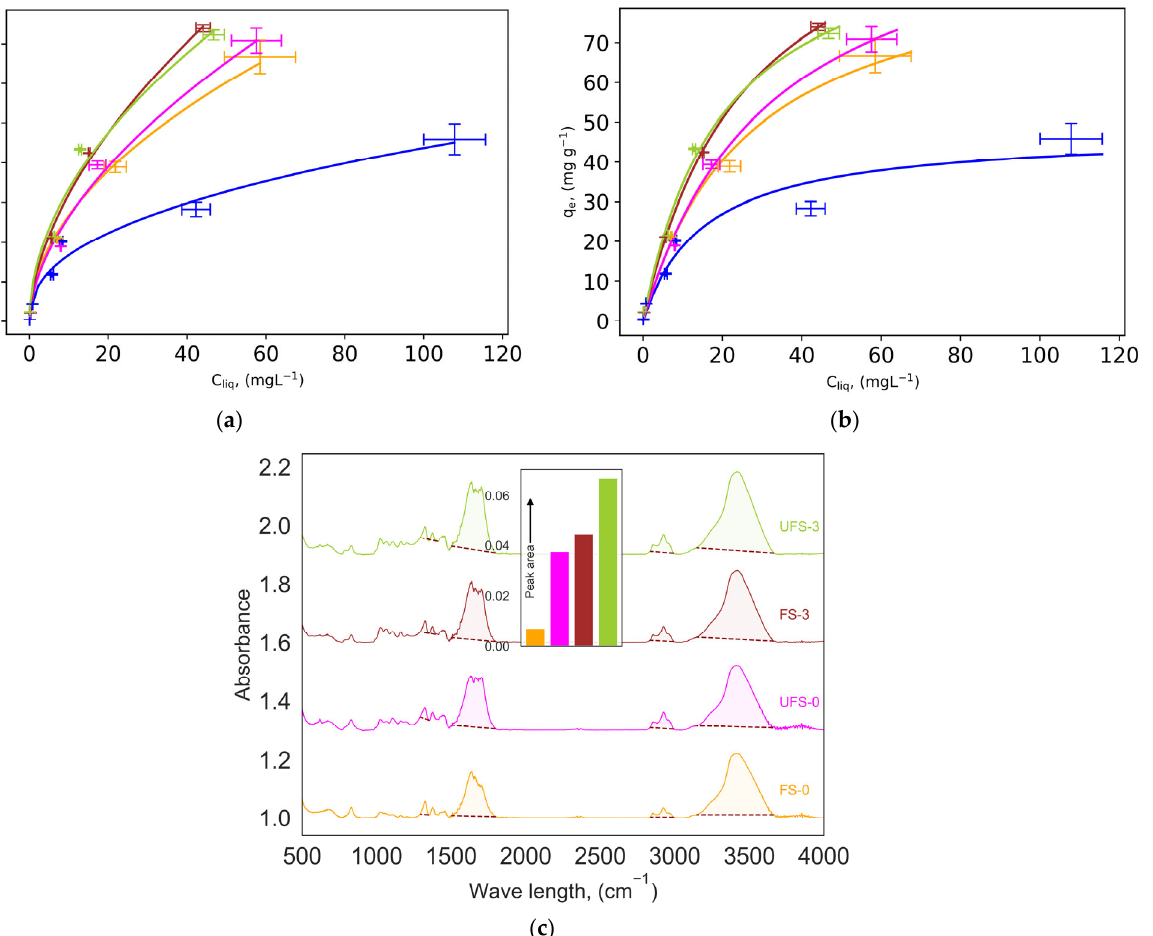
Figure 3. ( a ) Freundlich and ( b ) Langmuir adsorption isotherms and ( c ) comparison of surface area underneath (colored part) the FTIR spectra for: ( ─ ) FS ‐ 0; ( ─ ) UFS ‐ 0; ( ─ ) FS, W:B = 3; ( ─ ) UFS ‐ 3; ( ─ ) Dry S, W:B = 3 at reaction temperature of 210 °C and reaction time of 4 h. Table 2. Adsorption isotherm parameters of MB adsorption onto different hydrochar. Freundlich